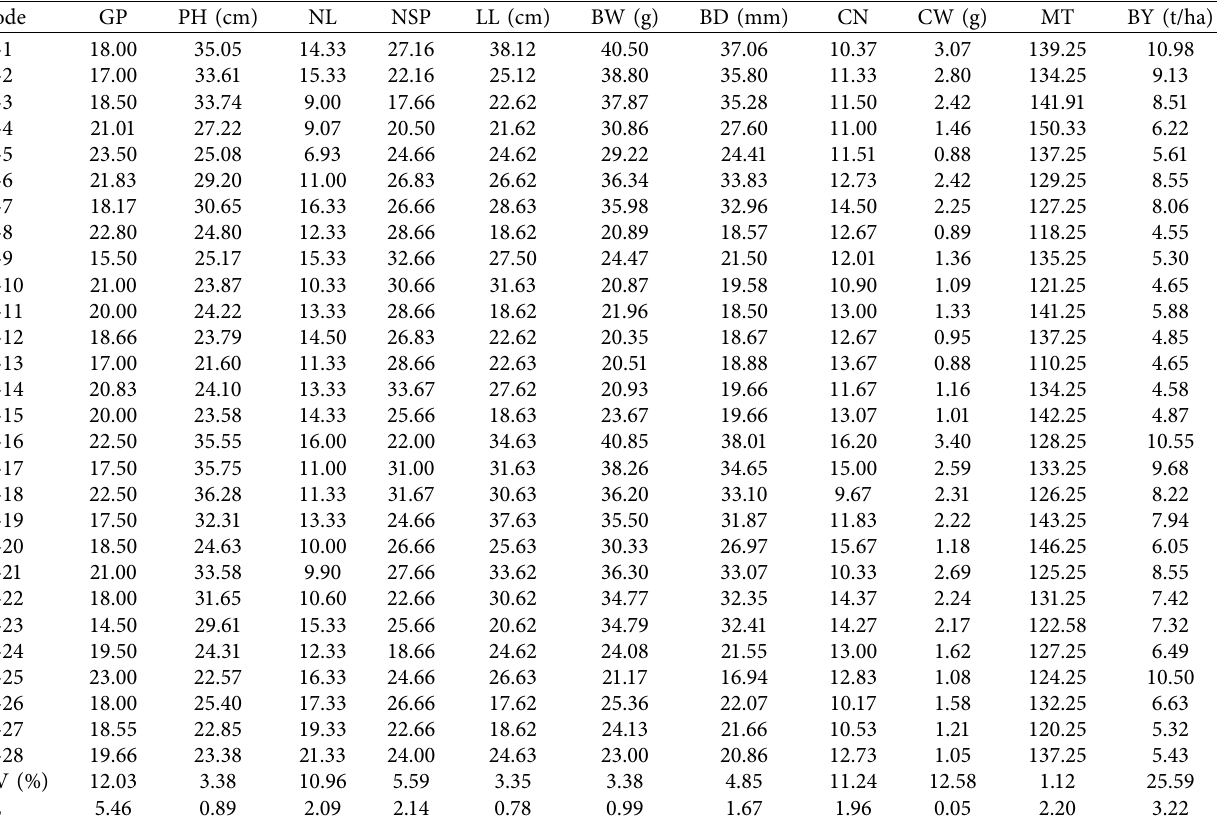
Table 3: The mean performance of 28 garlic accessions in Ezo-Otte in the Chencha district of the Gamo highlands in southern Ethiopia in main cropping season, 2017.